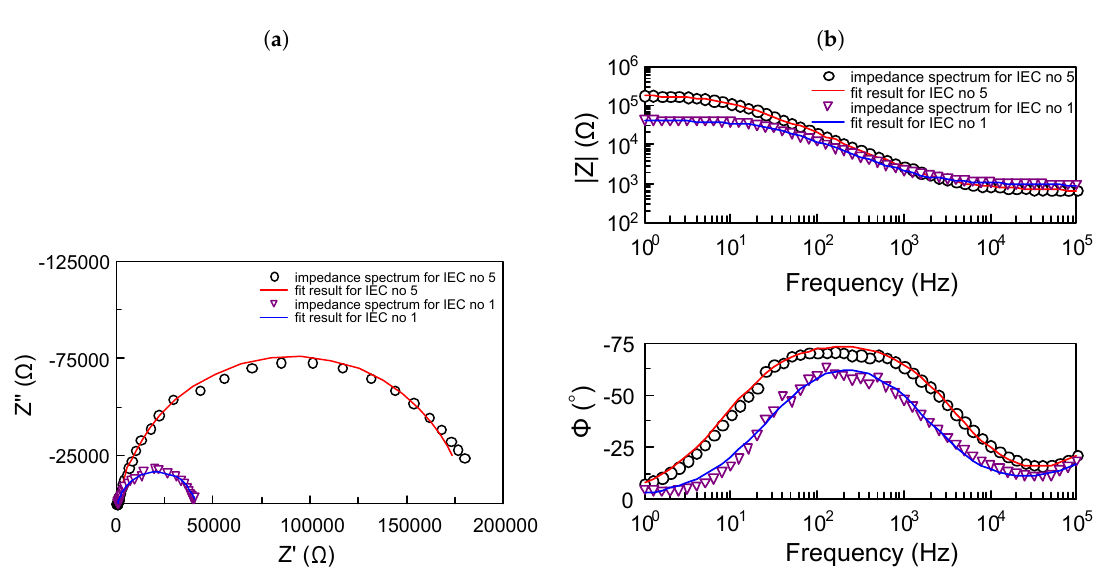
Figure 8. Impedance spectra and its approximation for sensors no 1 and 5 in PBS solution with the presence of Fe 2 + /3 + ions and BSA: ( a ) Z (cid:48)(cid:48) = f ( Z (cid:48) ) , ( b ) | Z | = f ( f ) and Φ = f ( f ) .